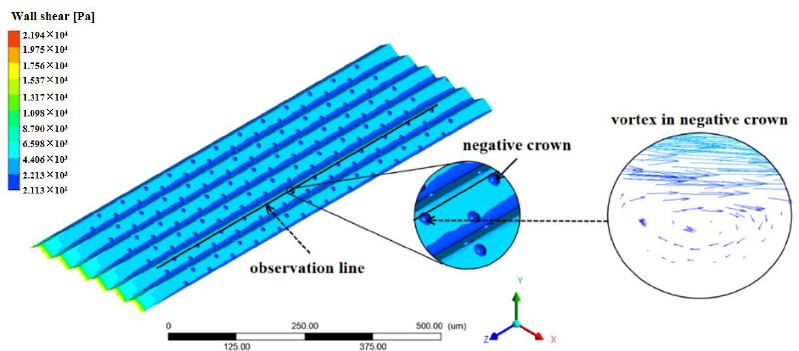
Figure 11. The wall sheer stress of negative crown microstructure at 12 m/s, and the vortex in negative crown.